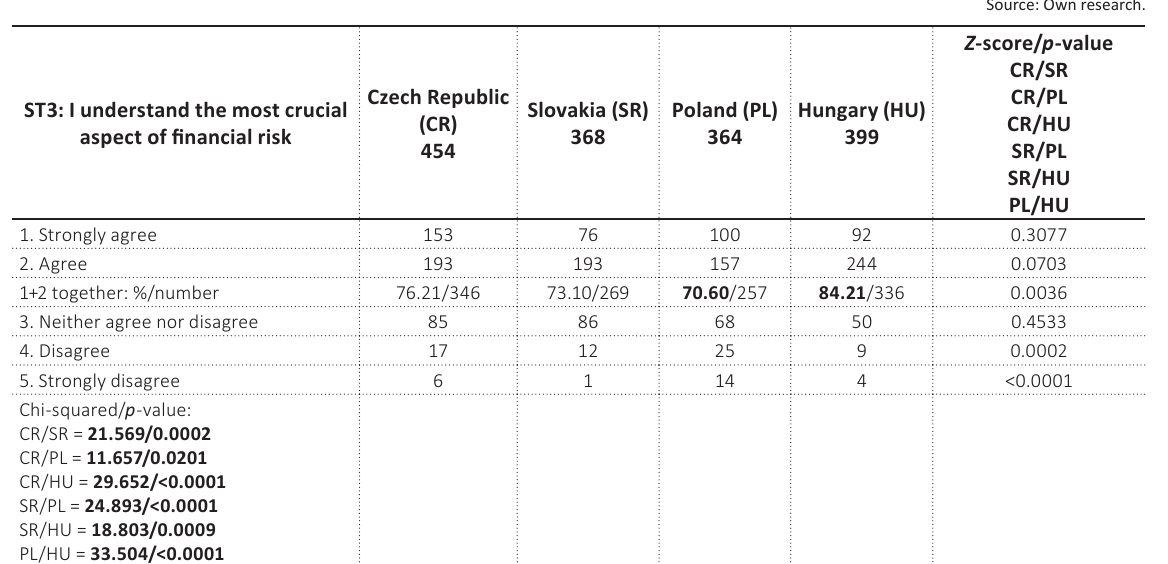
Table 3. Evaluation of financial risk management knowledge in the V4 countries